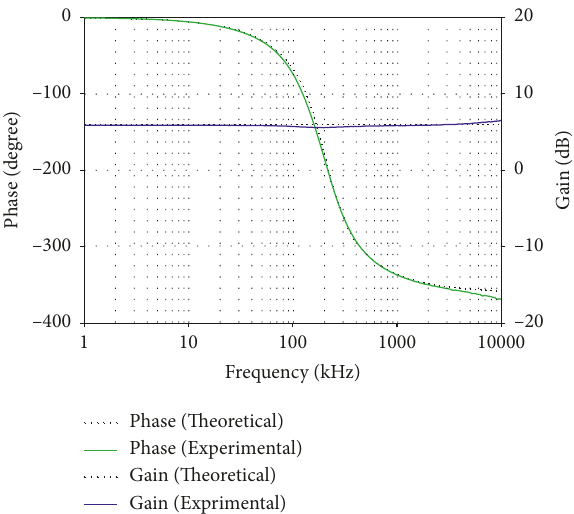
Figure 9: Experiment gain and phase response of all-pass